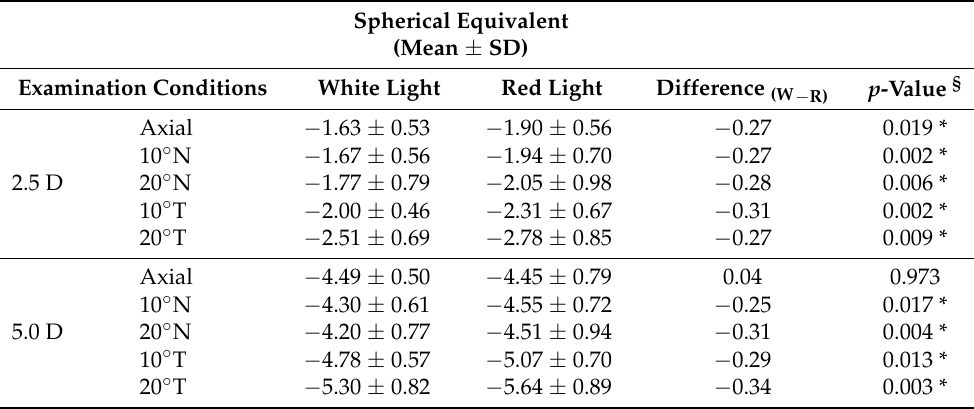
Table 1. Spherical equivalent (mean ± standard deviation) with both illumination conditions (red and white light) at each eccentricity and accommodative demand. (N: nasal retina; T: temporal ret- ina).